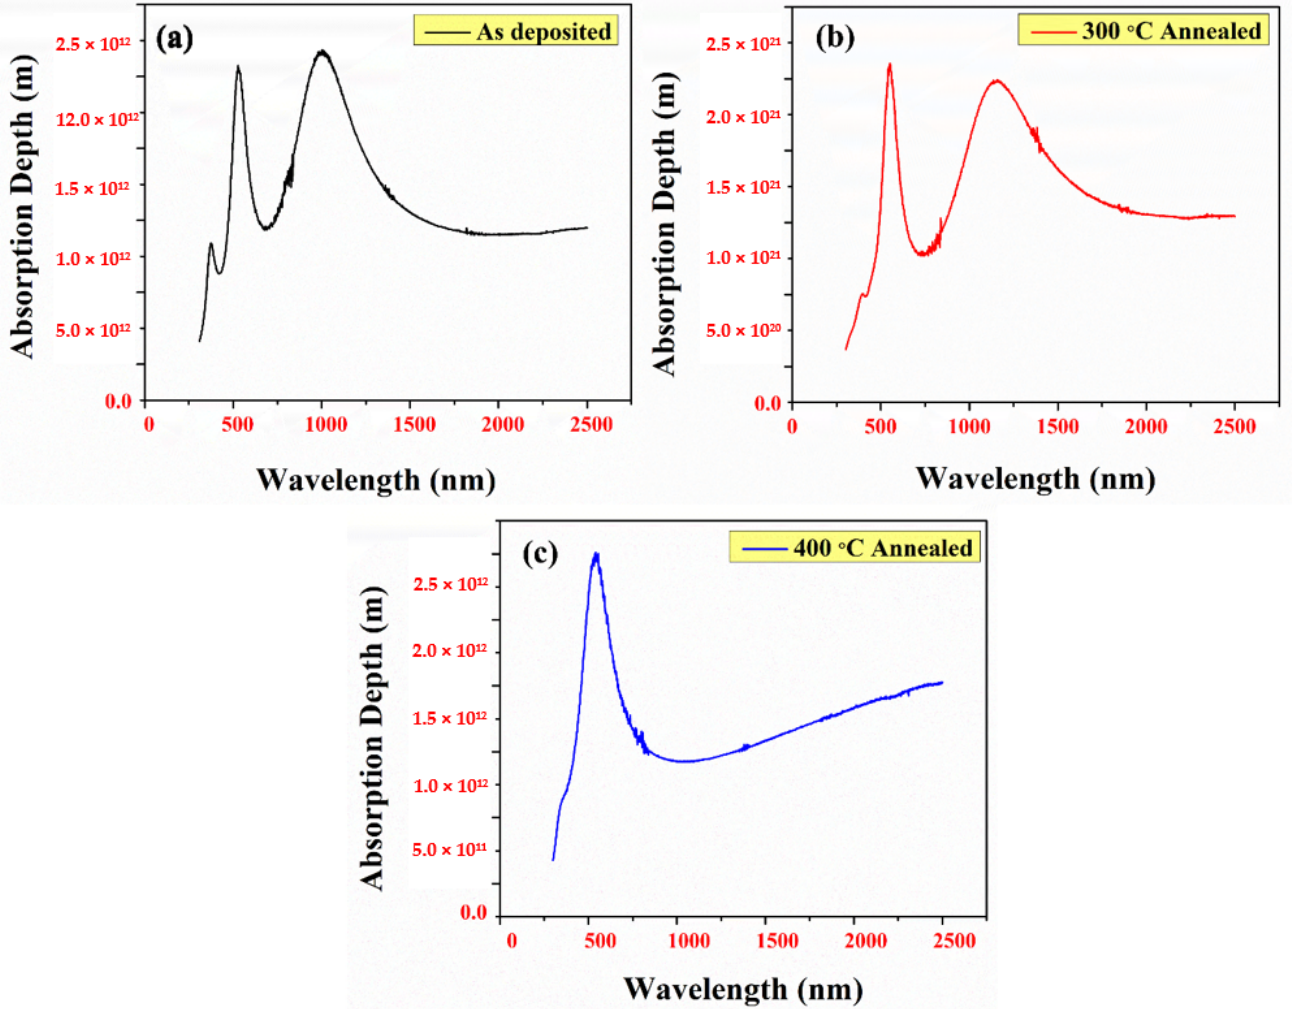
Figure 4. Absorption depth ( α ) vs. wavelength (nm) of multi-layered HfO 2 /V 2 O 5 /HfO 2 thin films: ( a ) as-deposited; ( b ) annealed at 300 ◦ C; and ( c ) annealed at 400 ◦